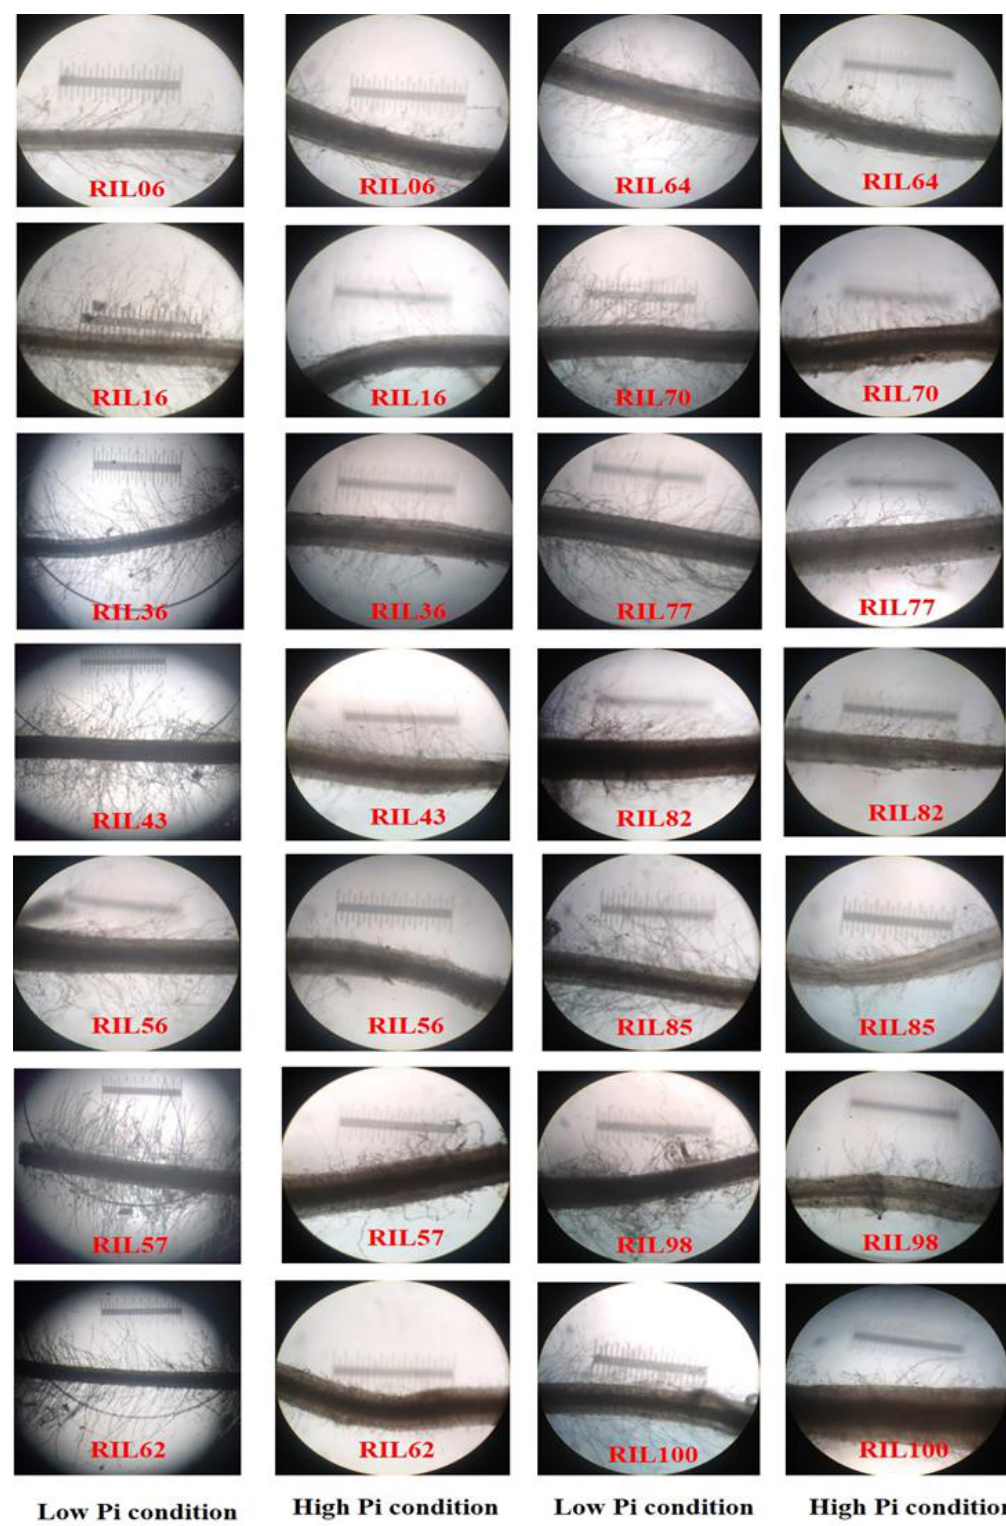
Figure 1. Root hair images of selected F 2:3 RILs of finger millet grown under LP and HP conditions in the greenhouse. These images were taken after 30 days of growth under these conditions, using 109 magnifications in a microscope (Leitz Wetzlar Germany 513,558 (Model no. Laborlux 12)).